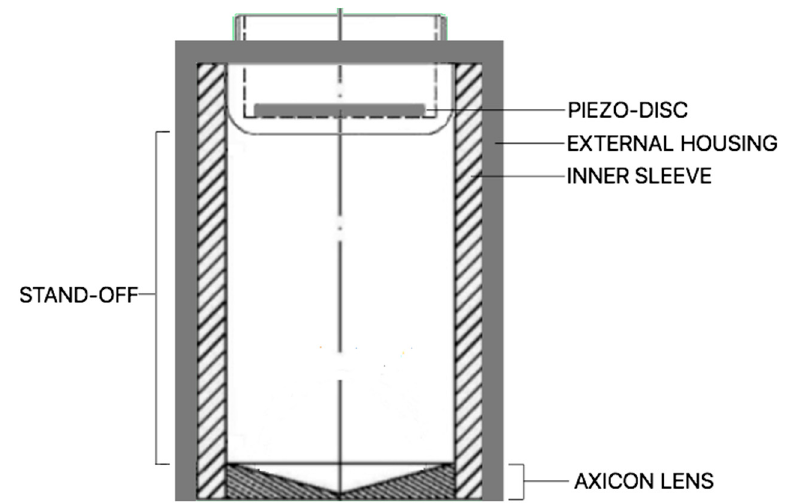
Figure 5. Housing of the axicon lens.